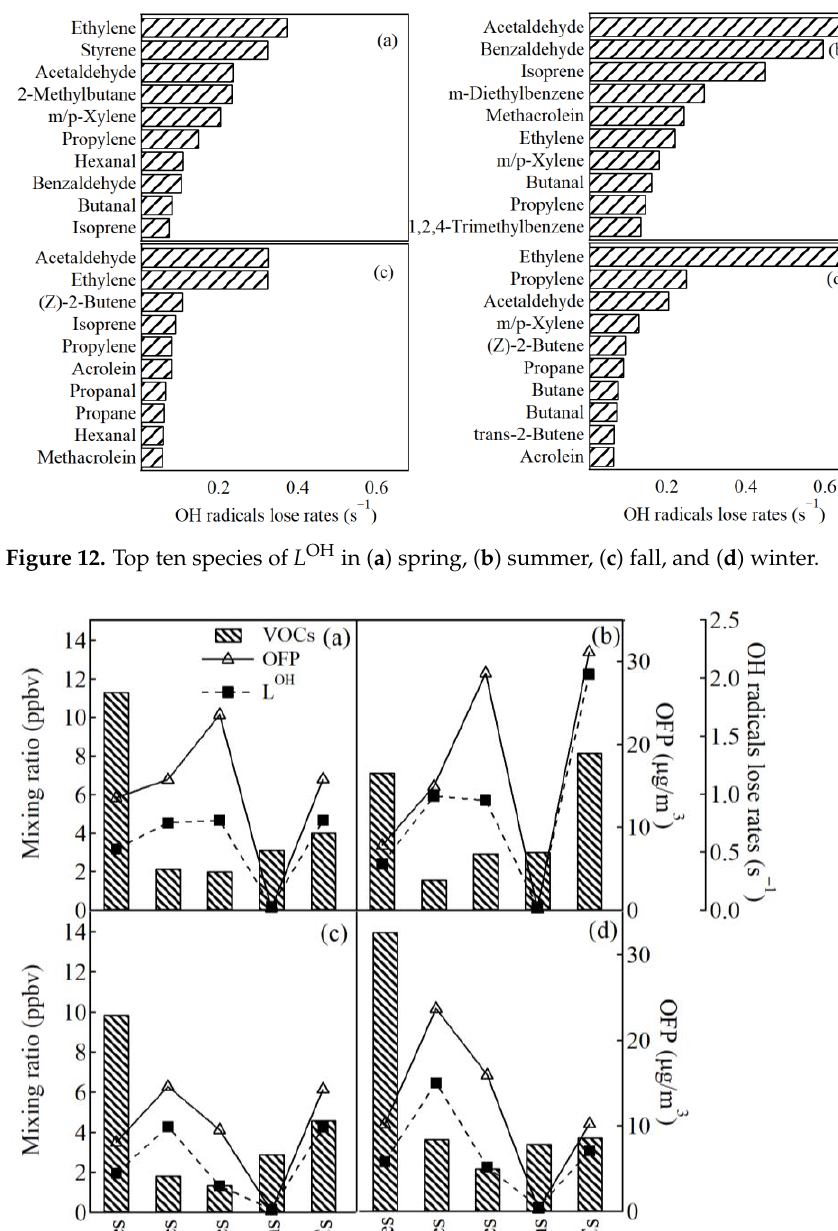
Figure 14. Top ten species of OFP in ( a ) spring, ( b ) summer, ( c ) fall, and ( d ) winter. 3.4.3. SOAP of VOCs The calculated SOAP values were 0.25 μg/m 3 , 0.34 μg/m 3 , 0.39 μg/m 3 , and 0.16 μg/m 3 in spring, summer, fall, and winter, respectively (Table S5). The most important contribu- tors to SOA were aromatics. The top ten VOC species contributing to the total SOAP are listed in Figure 15a – d. The VOC species with the largest contribution to SOA in all seasons